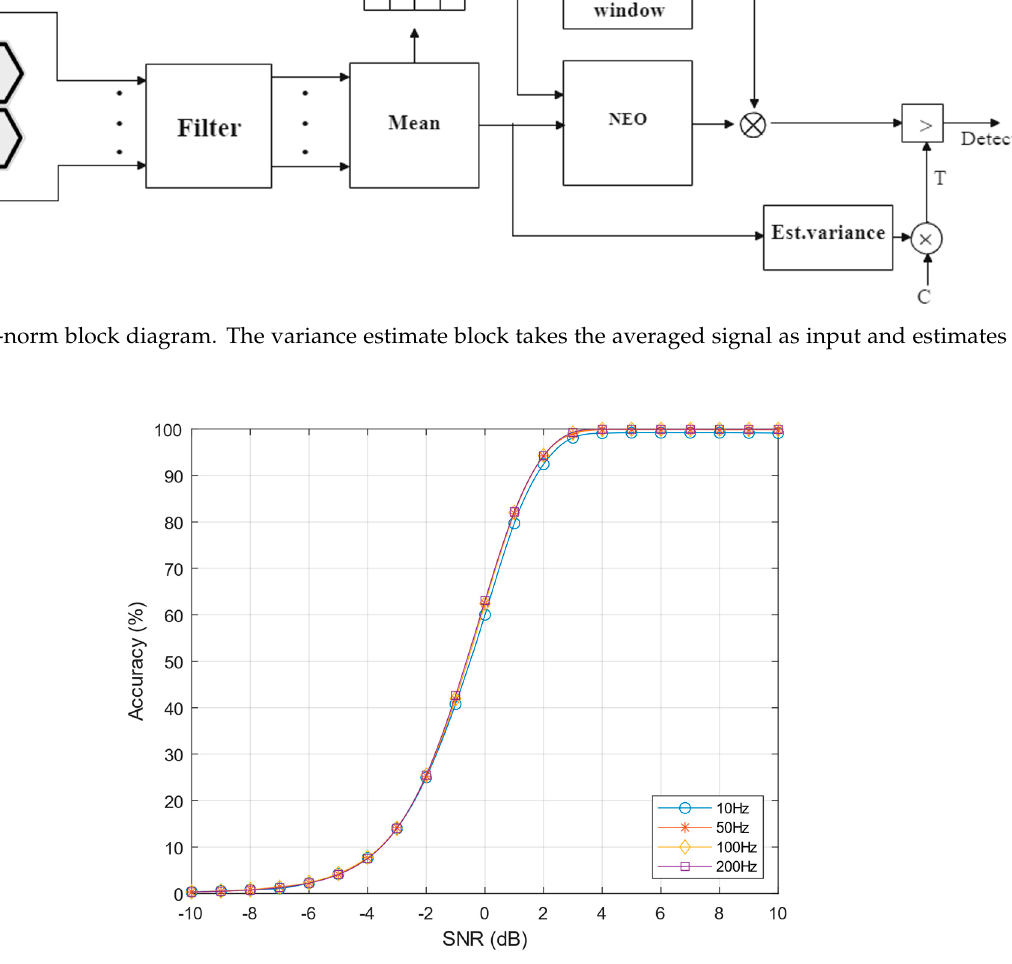
Figure 11. Performance of post-norm algorithm varying the neurons firing rates from 10–200 Hz, k = 4 and C = 50.